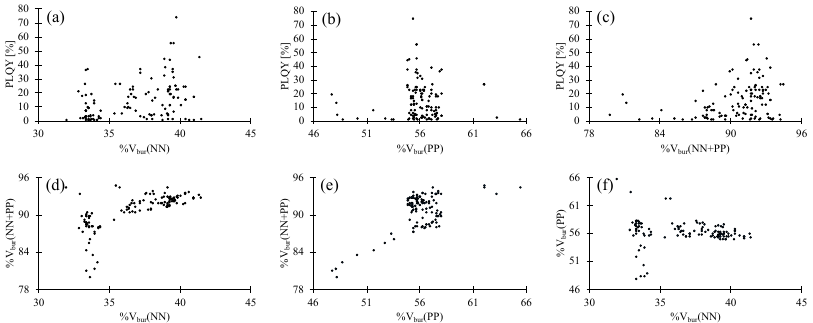
Figure 2. Scatter plots of photoluminescence quantum yield (PLQY), %V bur (NN), %V bur (PP) and %V bur (NN + PP) for all 100 compounds [17–21,23–27,30–48]. ( a ) Scatter plot of PLQY vs. %V bur (NN). ( b ) Scatter plot of PLQY vs. %V bur (PP). ( c ) Scatter plot of PLQY vs. %V bur (NN + PP). ( d ) Scatter plot of %V bur (NN) vs. %V bur (NN + PP). ( e ) Scatter plot of %V bur (PP) vs. %V bur (NN + PP). ( f ) Scatter plot of %V bur (NN) vs. %V bur (PP).